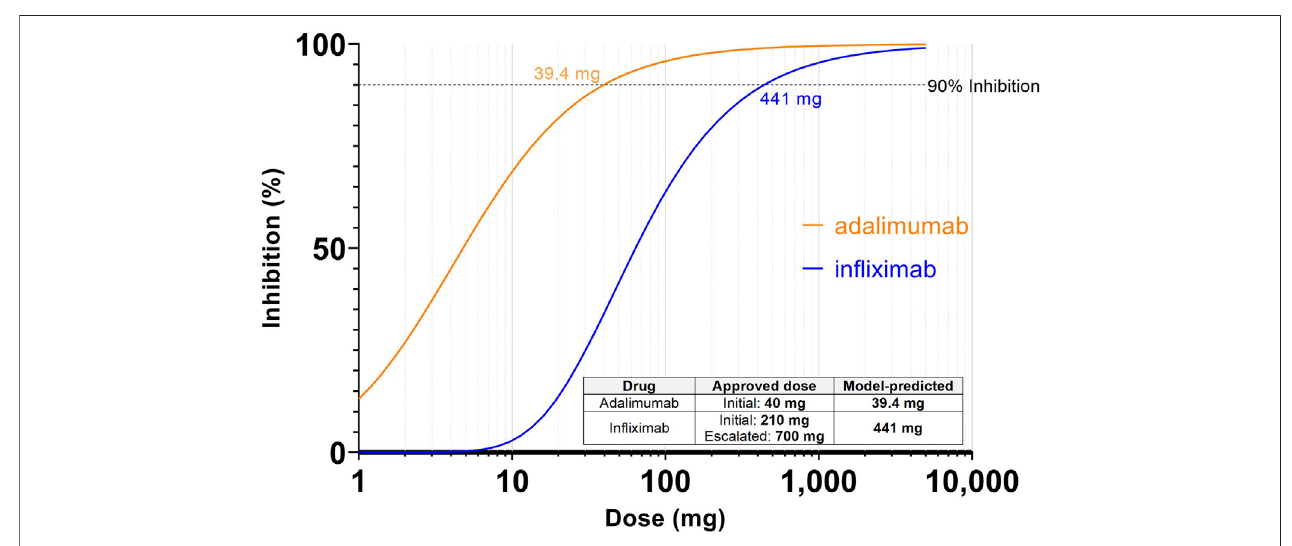
FIGURE 2 | Simulations predicting dose to achieve 90% inhibition of TNF:TNFR complex for adalimumab and in fl iximab. Inhibition is de fi ned as reduction from the pretreatment target ligand:receptor binding at the steady state trough. Inset table shows the model-predicted dose based on inhibition vs. clinically approved dose for each drug. For in fl iximab, the milligram dosage assumes a 70 kg